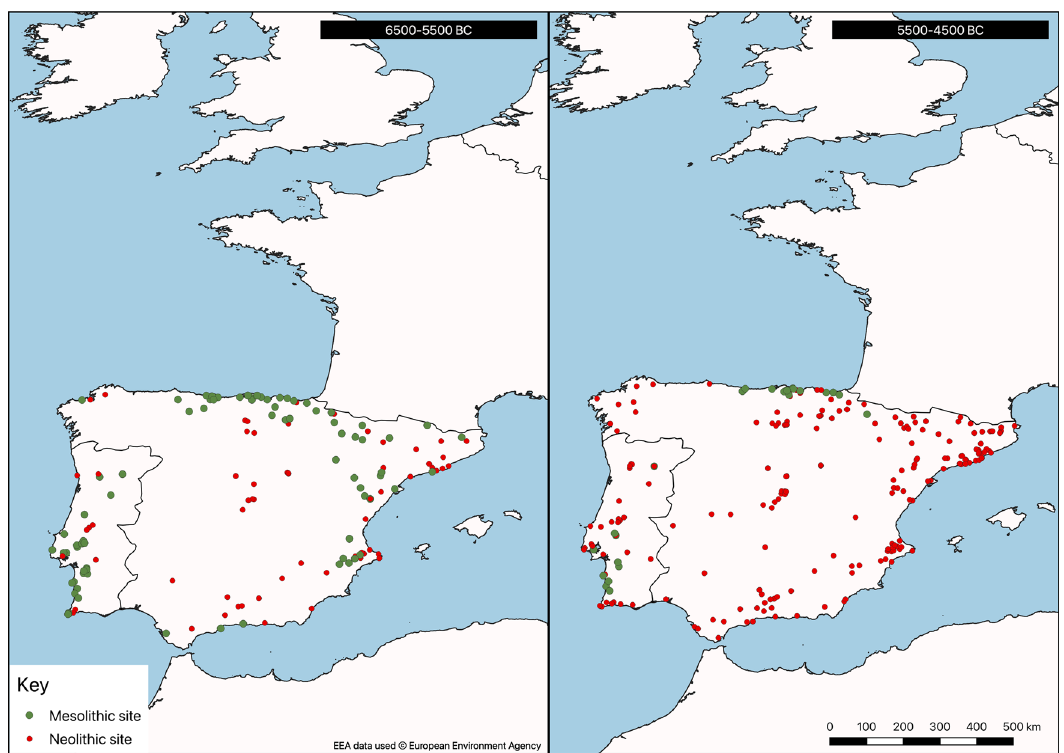
Figure 9: Location of Mesolithic sites ( red ) and Neolithic sites ( green ) from 6500 to 5500 BC ( left ) and 5500 to 4500 BC ( right ) in Spain. Data obtained from Pardo - Gordó et al.,